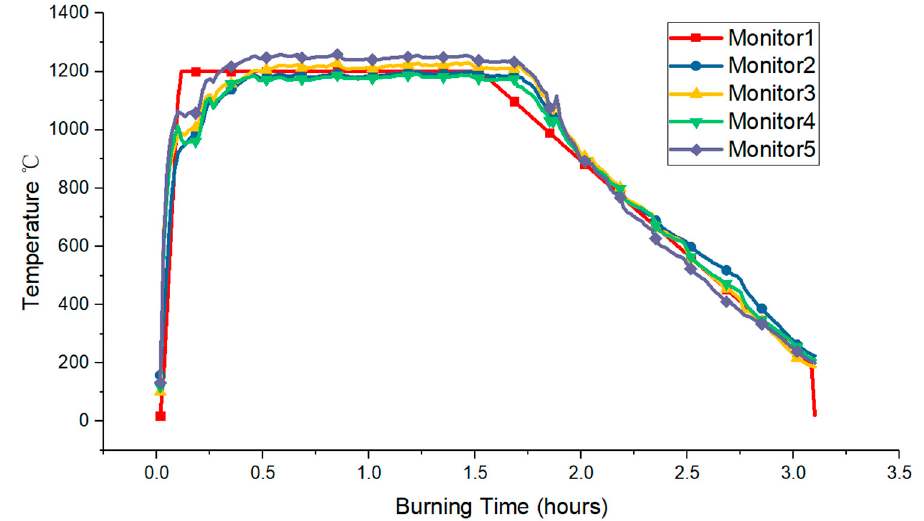
Figure 6. The temperature-rise curve inside of the furnace (RABT curve).